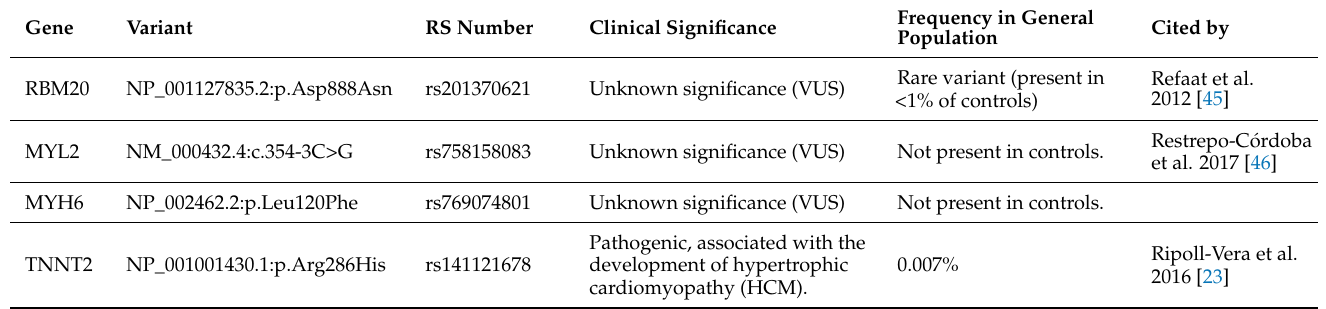
Table A1. Additional genetic variants identified in the studied cohort, within their attributed clinical significance and estimated frequency in general population according to the literature